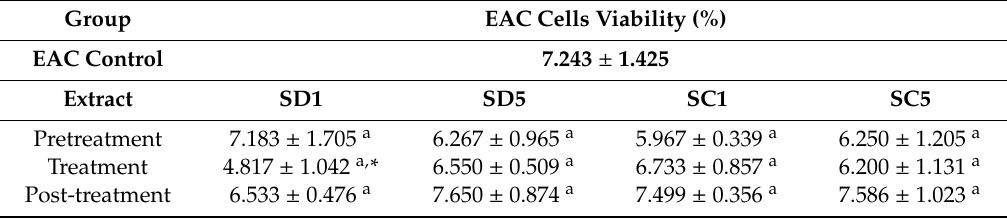
Table A2. Impact of S. montana extracts on the viability of EAC cells.